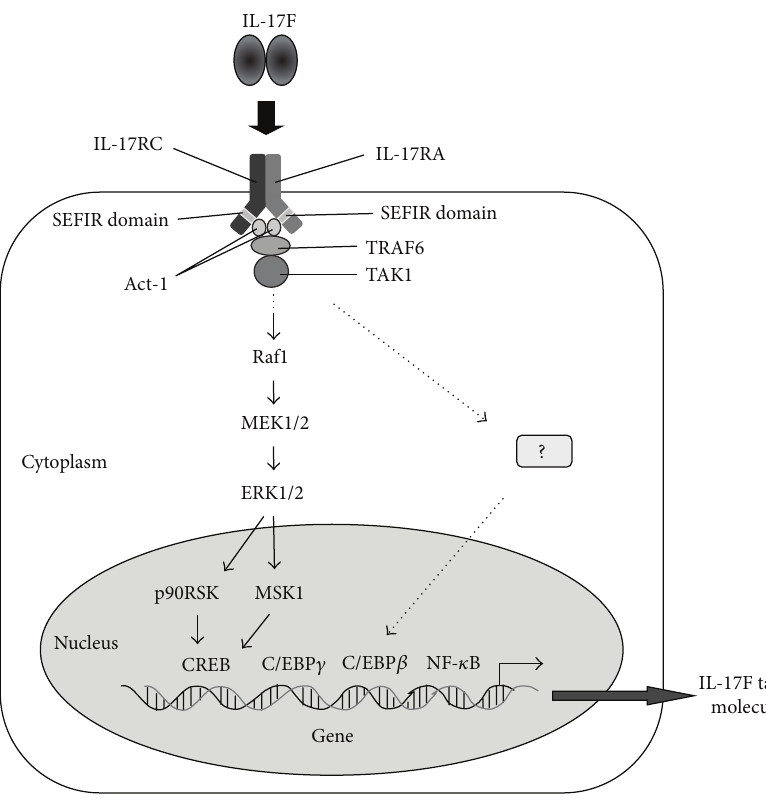
Figure 2: Signaling pathways induced by IL-17F. IL-17F utilizes a heterodimer of IL-17RA and IL-17RC as its receptor, and then IL-17RA engages the SEFIR domain-containing Act-1. Act-1 is required for recruitment of TRAF6, leading to the activation of TAK1. The Raf1- MEK1/2-ERK1/2-p90RSK/MSK1-CREB is the pivotal signaling pathway. On the other hand, IL-17F also activates transcriptional factors such as C/EBP 𝛽 , C/EBP 𝛾 , and NF- 𝜅 B. Activation of these pathways leads to the expression of various inflammatory